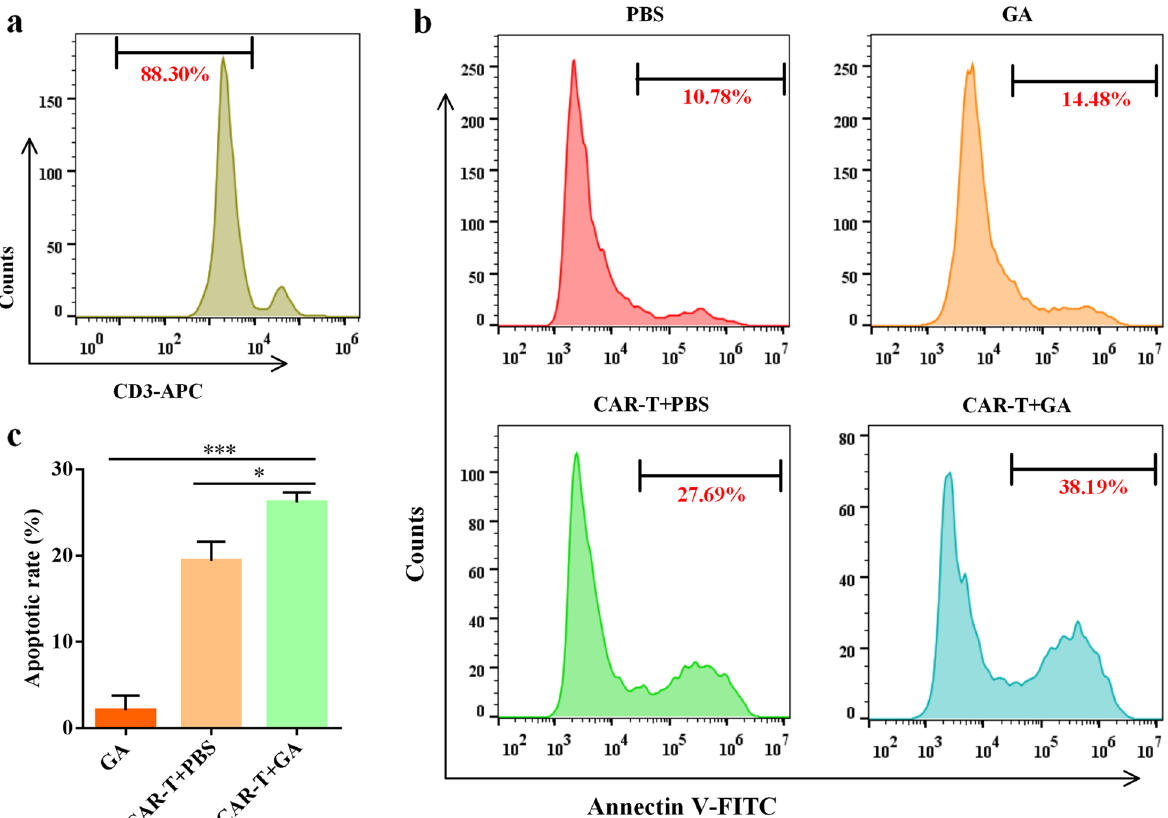
Fig. 2 GA enhanced the cytotoxic function of anti-CD19 CAR-T cells in vitro. a Representative FACS plot for identifying Raji cells (CD3-negative cells). b Representative FACS analysis of the apoptosis of Raji cells. c The apoptotic rate of Raji cells after normalized to no CAR-T cell/GA wells (PBS group). * P < 0.05; *** P < 0.005 ( n 3). The concentration of GA was 100 μM and the effector: target ratio was =